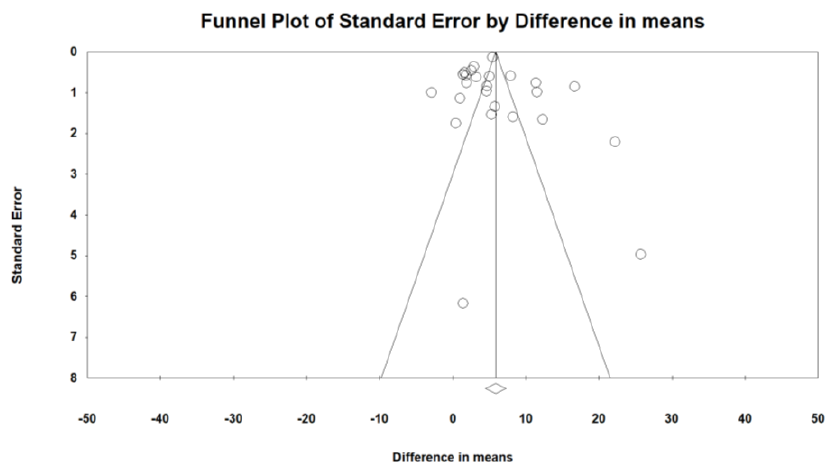
Figure 2. Funnel plot detailing publication bias in the publications describing the effect of bariatric surgery on FMD.